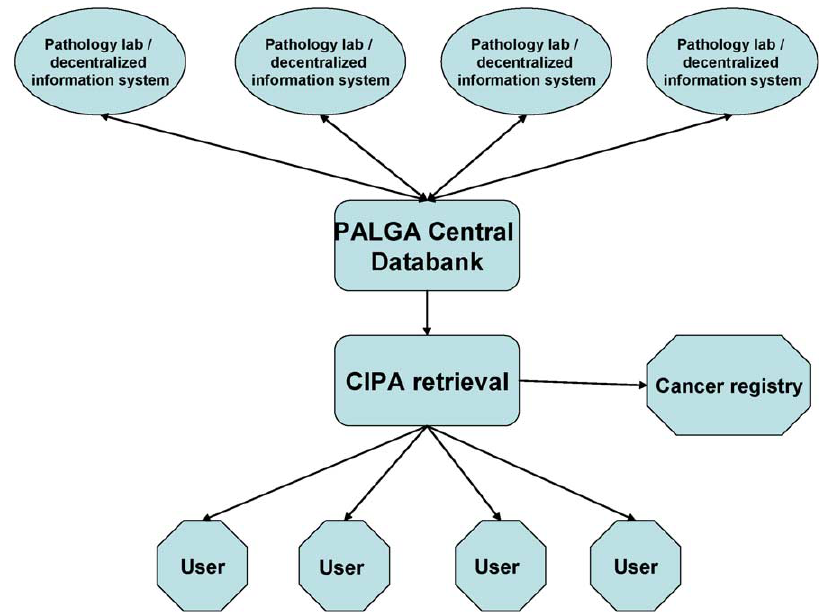
Fig. 1. Organizational scheme of the PALGA system with decentralized input by local laboratories, the central databank and information exchange technology providing authorized users access to the data. The CIPA retrieval box is the interface that allows queries based on diagnosis codes, demographic factors and conclusion texts of pathology